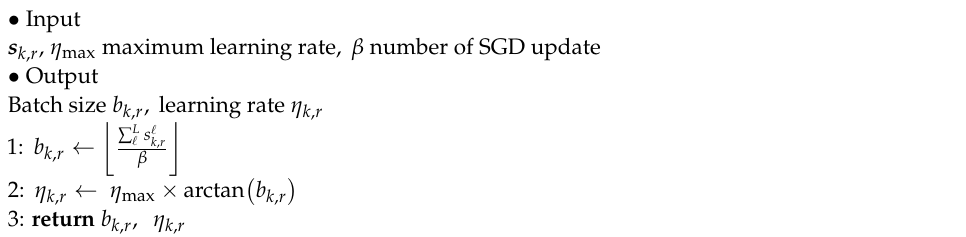
Algorithm 3. DynamicBL. dynamically allocate batch size and learning rate.